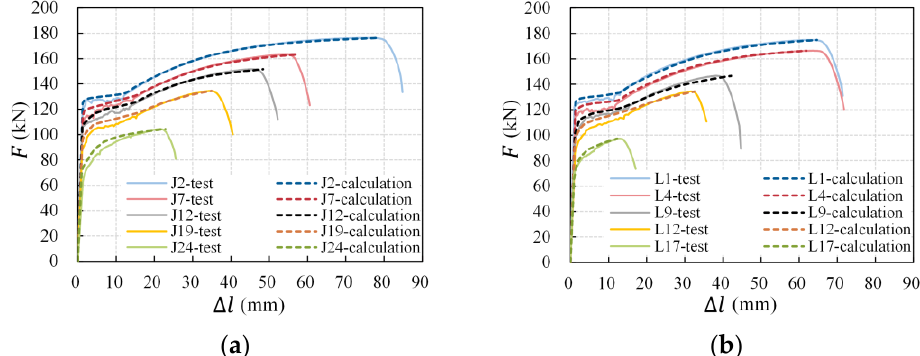
Figure 19. Calculation of load-deformation curves of corroded rebars: ( a ) intact slabs; ( b ) pre-cracked slabs. Table 6. Tensile deformation at the maximum load based on various cross-sectional area data.